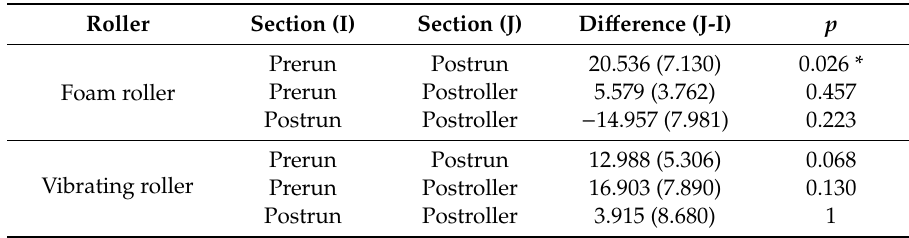
Table 4. Two-way ANOVA posthoc analysis of SBF